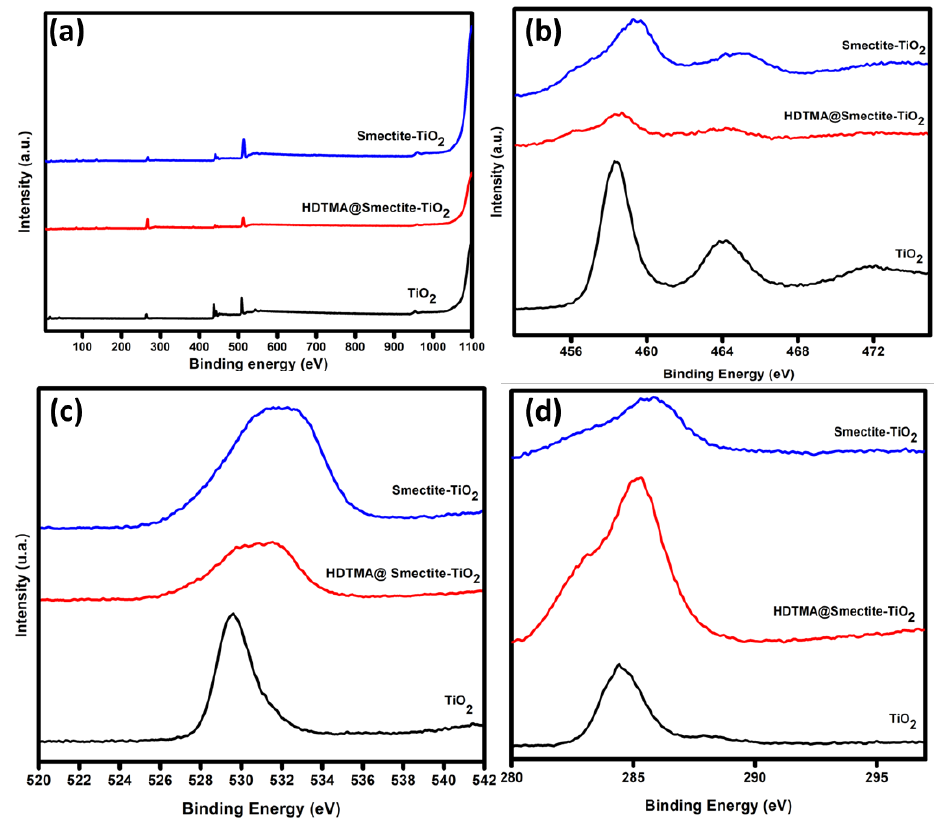
Figure 2. ( a ) XPS survey spectra of TiO 2 , Smectite-TiO 2 , and HDTMA@Smectite-TiO 2 samples. ( b ) Ti2p high-resolution profiles. ( c ) O1s high-resolution profiles. ( d ) 1Cs high-resolution profiles.